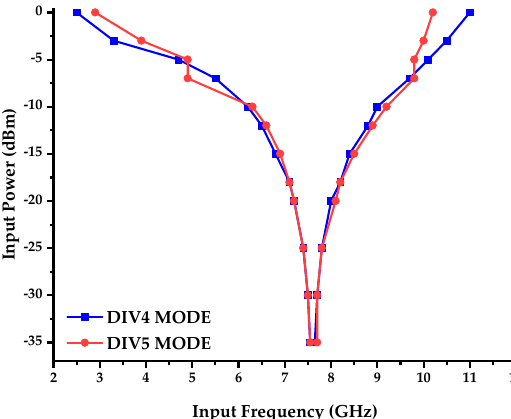
Figure 5. Simulation result of the input sensitivity curves of the prescaler.